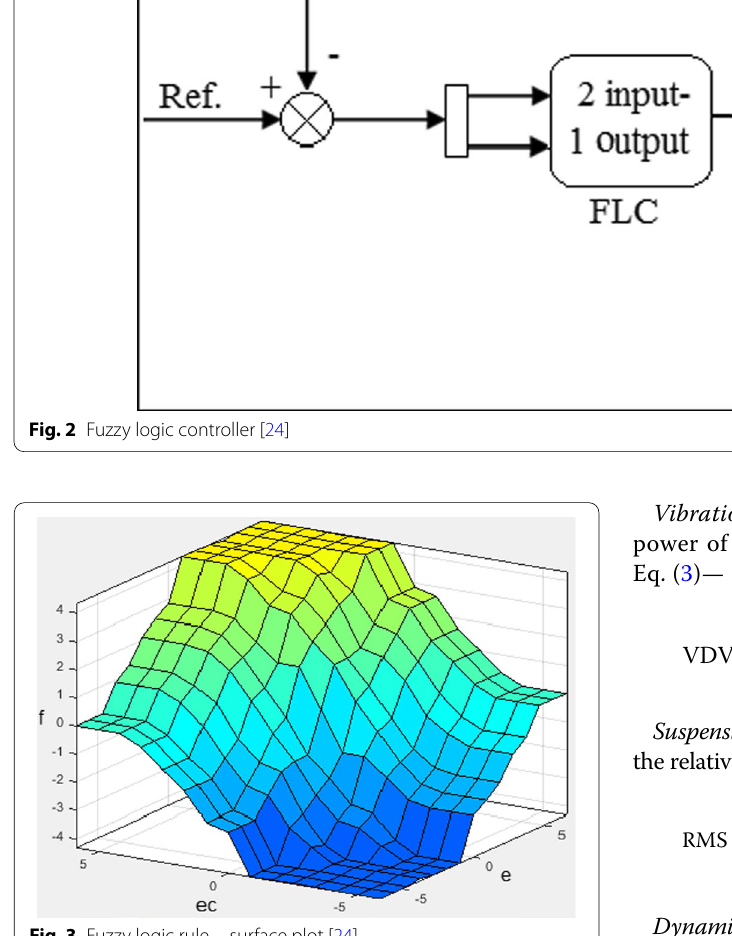
Fig. 3 Fuzzy logic rule—surface plot